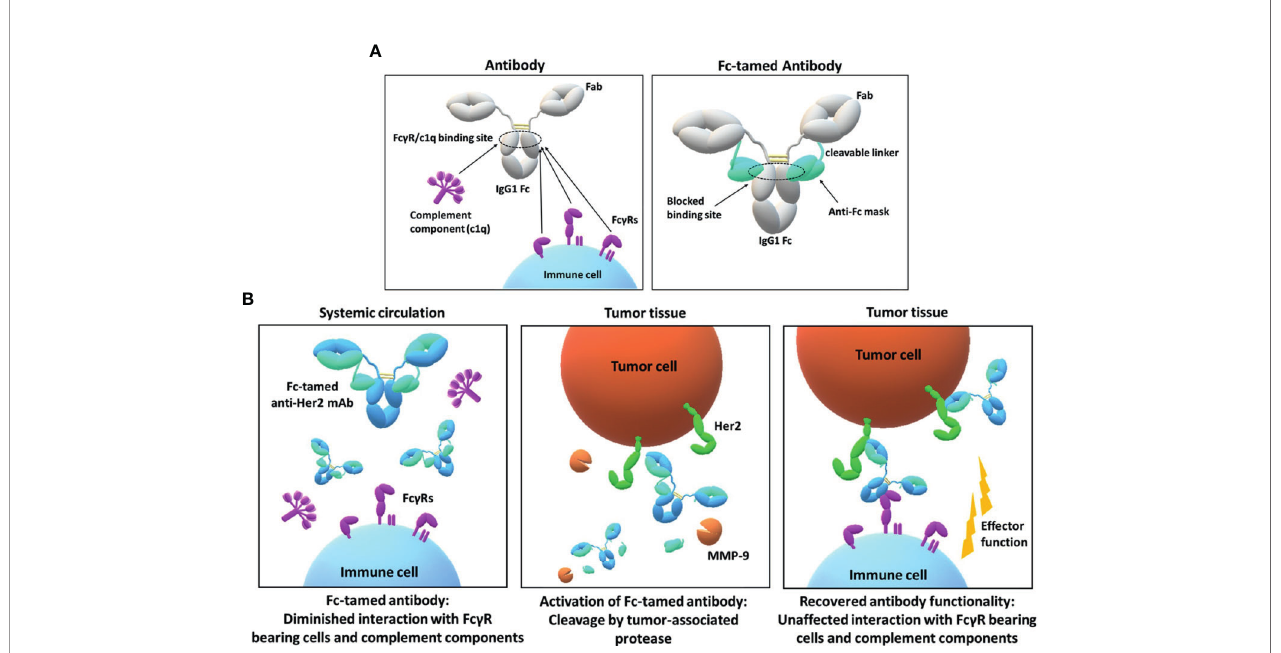
FIGURE 1 | Design and mode of action of the Fc-tamed antibodies. (A) Depiction of overlapping Fc g R and c1q interaction sites located on the CH2 domain of an IgG1 antibody (left panel). Molecule design of the Fc-tamed antibodies, comprising two antibody heavy chains (IgG1) and two light chains, C-terminally fused to a protease-cleavable linker and a Fc g R-blocking anti-isotypic masking unit (right panel). (B) Conceptional mode of action of a Fc-tamed anti-Her2 monoclonal antibody. After administration and during systemic circulation, Fc-tamed antibodies exhibit diminished interaction to Fc g R-bearing cells and complement components (c1q) (left panel). Entering the tumor microenvironment, the Fc-tamed antibodies are activated upon linker proteolysis by tumor-speci fi c proteases (MMP-9) (middle panel). The active antibody demonstrates recovered ability to induce antibody-mediated effector functions (right